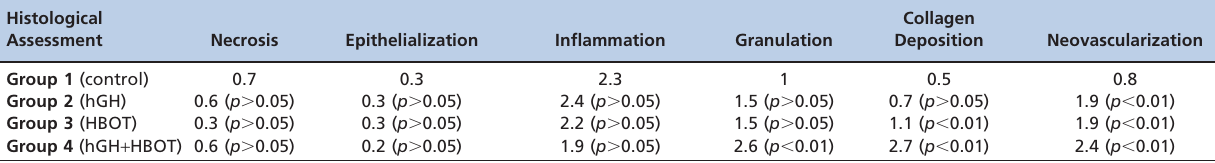
Table 3 - Histological assessments in the non-ischemic groups (all parameters scored from 0 to 3). The p -value compares group 1 to the other